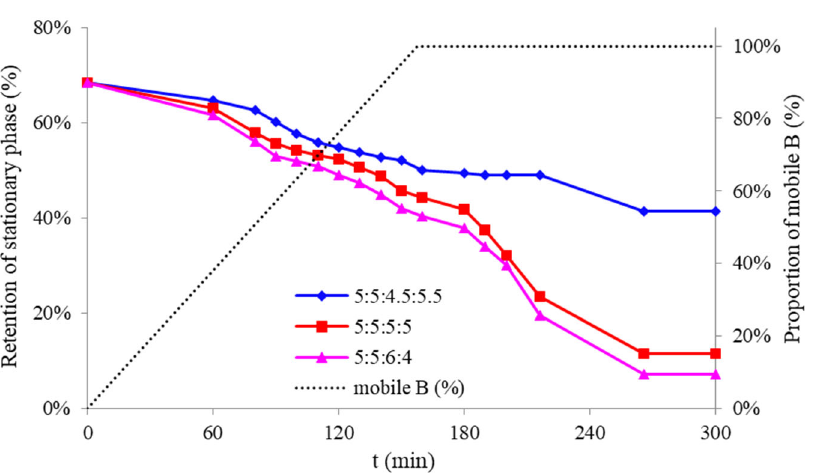
Figure 2. The linear gradient CCC procedure tested with different solvent systems. Stationary